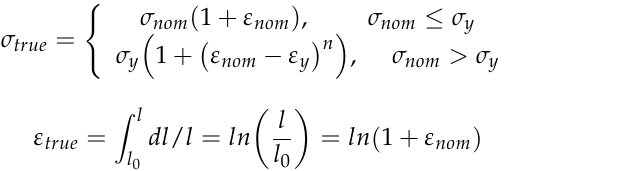
Figure 12. 1/4 Finite element models and data collection lines along the longitudinal direction from the center of the BF joint to the tip of the specimen (unit: mm): ( a ) Type A model (110 SDR 9); ( b ) Type B model (315 SDR 11); ( c ) points of interest.